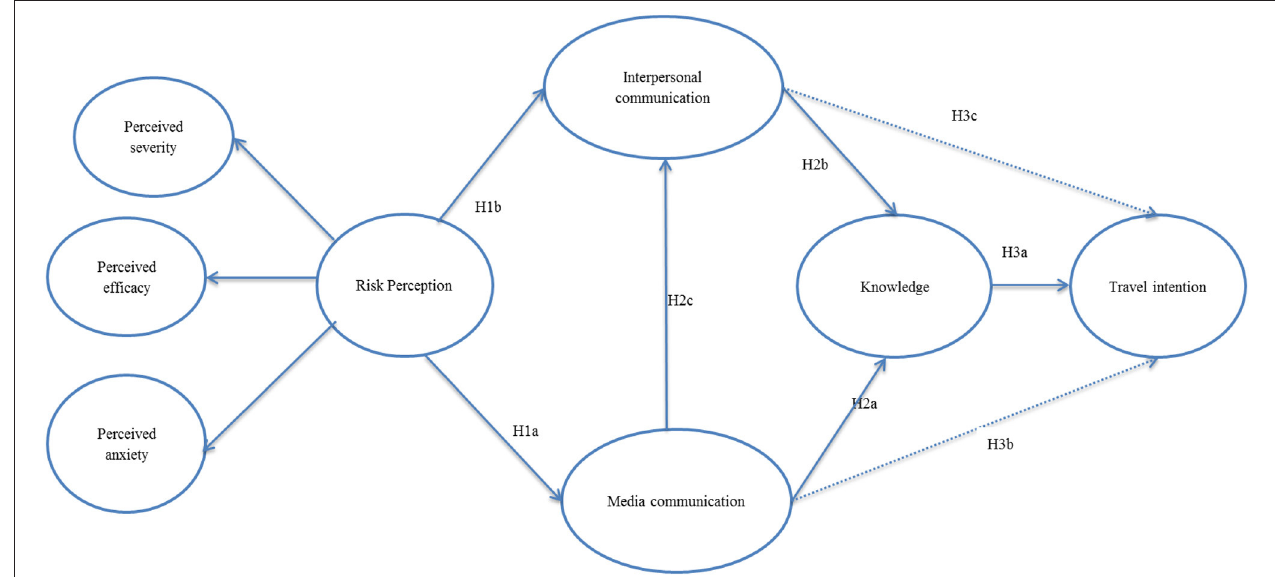
FIGURE 1 | Conceptual